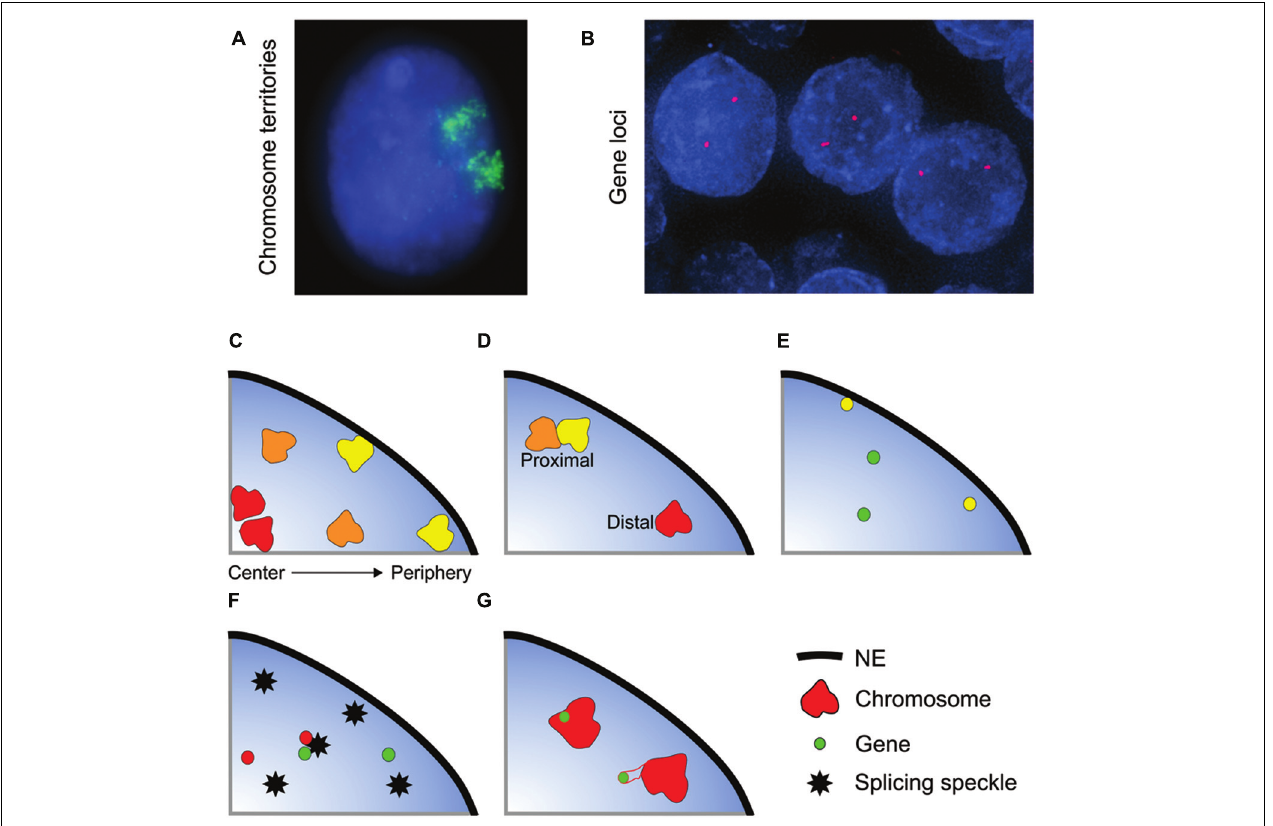
FIGURE 1 | Non-random organization of the genome. (A,B) Whole chromosomes and genes can be visualized within interphase nuclei using FISH. (A) Chromosome 11 (green) in an interphase nucleus (blue) of the breast epithelial cell line MCF10A. (B) SPDEF (red) gene loci in normal prostate tissue (formalin-fixed paraffin embedded tissue) nuclei (blue). The spatial organization of the genome is characterized in several ways: (C) Radial positioning describes the position of a locus relative to the center and periphery of the nucleus. Gene-poor chromosomes (yellow) generally locate to the nuclear periphery, whilst gene-rich chromosomes have a preference for the nuclear interior. (D–G) Relative positioning describes the position of a locus relative to another nuclear landmark. Association frequencies can either be measured on a per cell basis (i.e., the number of nuclei in a population with at least one copy of a gene or chromosome in close proximity to the given landmark) or on a per allele basis. Examples of types of relative positioning include: (D) The position of a locus relative to another locus. The yellow and orange chromosomes are in close spatial proximity, whereas the orange and red chromosomes are distal. (E) Association with the nuclear envelope (NE). Some genes preferentially co-localize with the NE (yellow gene). (F) Association with a nuclear body such as a splicing speckle. (G) The position of gene relative its own chromosome territory. Some gene rich loci loop out of the bulk of the chromosome territory when highly